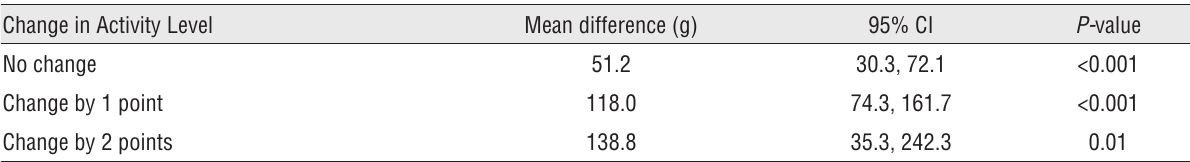
Table 2 - variation in Activity Level & Mean Change in pad weights.